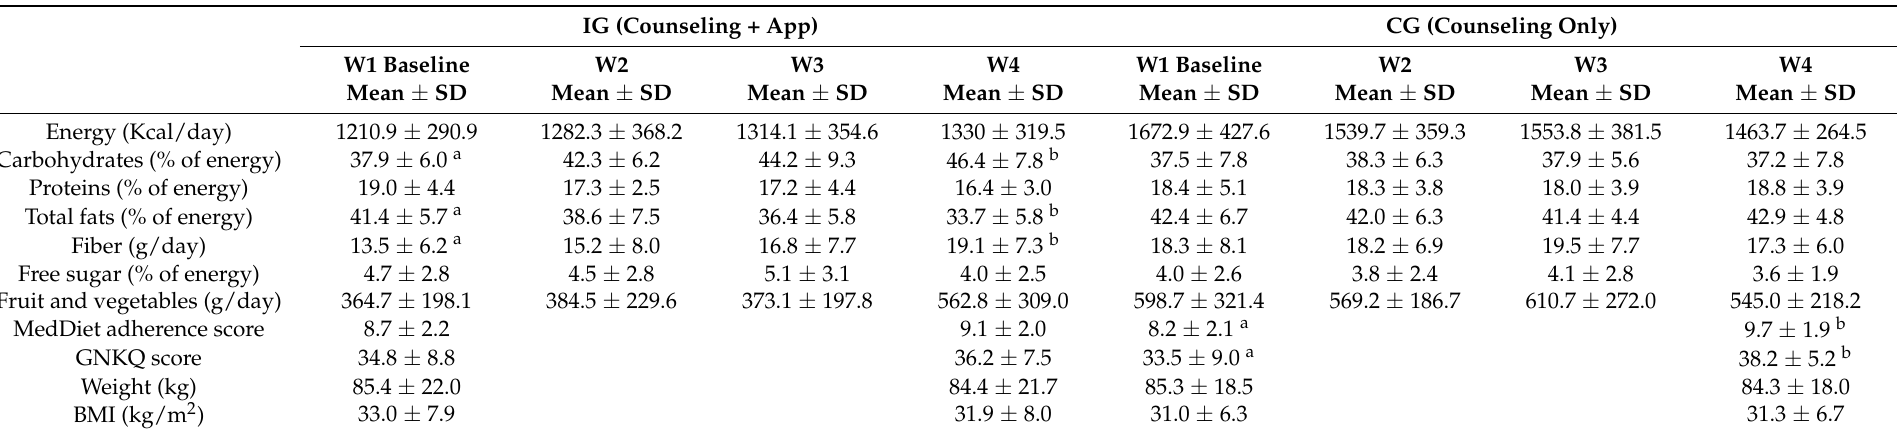
Table 2. Energy and macronutrients intake, adherence to MD, and nutritional data over a